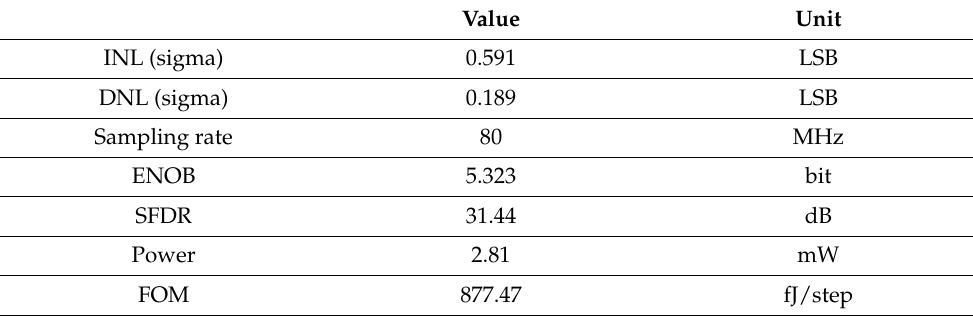
Table 2. Characteristics and measurements.